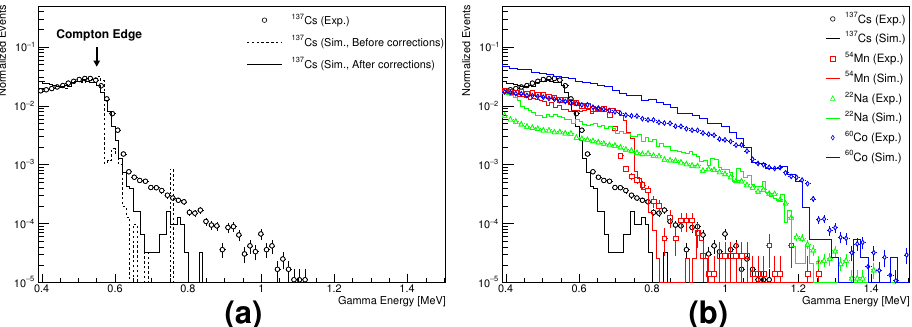
Figure 9. Pulse Height Distributions of the Compton Edge: ( a ) Before and After Corrections in the Simulation, and Data for 137 Cs. ( b ) Symbols and Solid Curves Represent Experimental Results and Corrected Simulation Results,